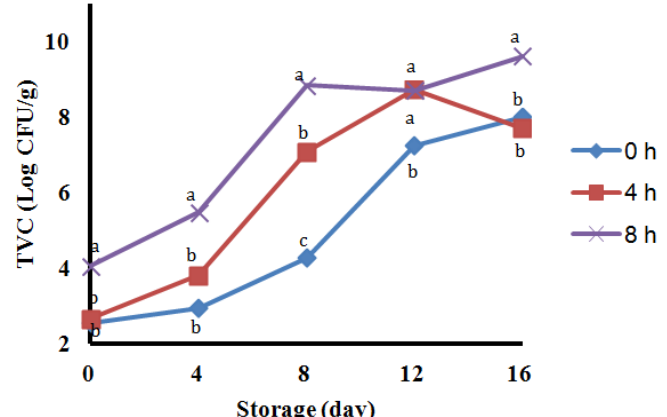
Figure 1. Changes in total viable counts (TVC) of carp stored in ice with 0, 4 and 8 h delay before